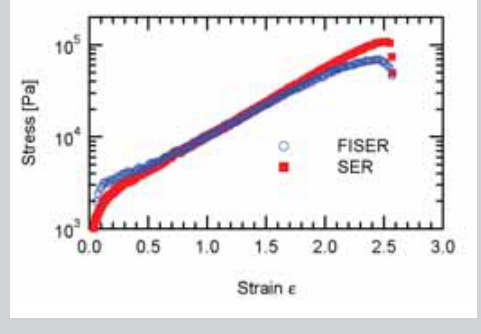
Figure 3: Deformation of a dough sample on the SER at E· = 10 s -1 . Slip leads to an actual deformation rate in the sample that is ~25 % slower than the nominal imposed value; however the strains remain approxi- mately uni-axial. True strains were calculated by measuring the change in length of material lines marked on the surface of the undeformed dough sample. Figure 4: Comparison of extensional behavior of a wheat flour dough recorded on the FISER E· versus SER at = 0.3 s -1